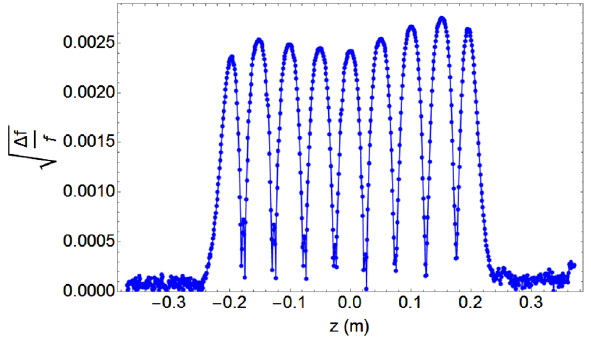
FIG. 25. The effect of the metal bead on the square root of the normalized frequency error in the reflected low-power rf signal as it travels through the cavity. As there is a zero on-axis E field in the middle of the cell, this quantity is a sufficient analog of the H field to determine the field